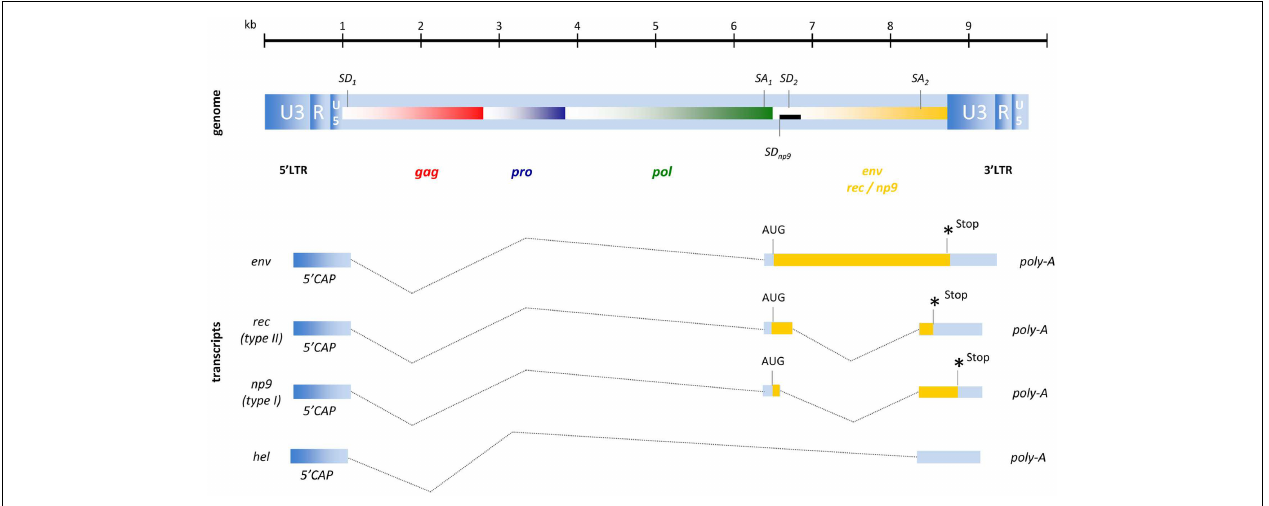
FIGURE 2 | Proviral organization of HERV-K(HML-2) and RNA transcripts .The black bar represents a 292-bp deletion that results in the Np9 gene product for type I proviruses instead of the Rec (an HIV-1 Rev homolog) characteristic of the type II proviruses. Hel is a poorly described RNA without protein coding